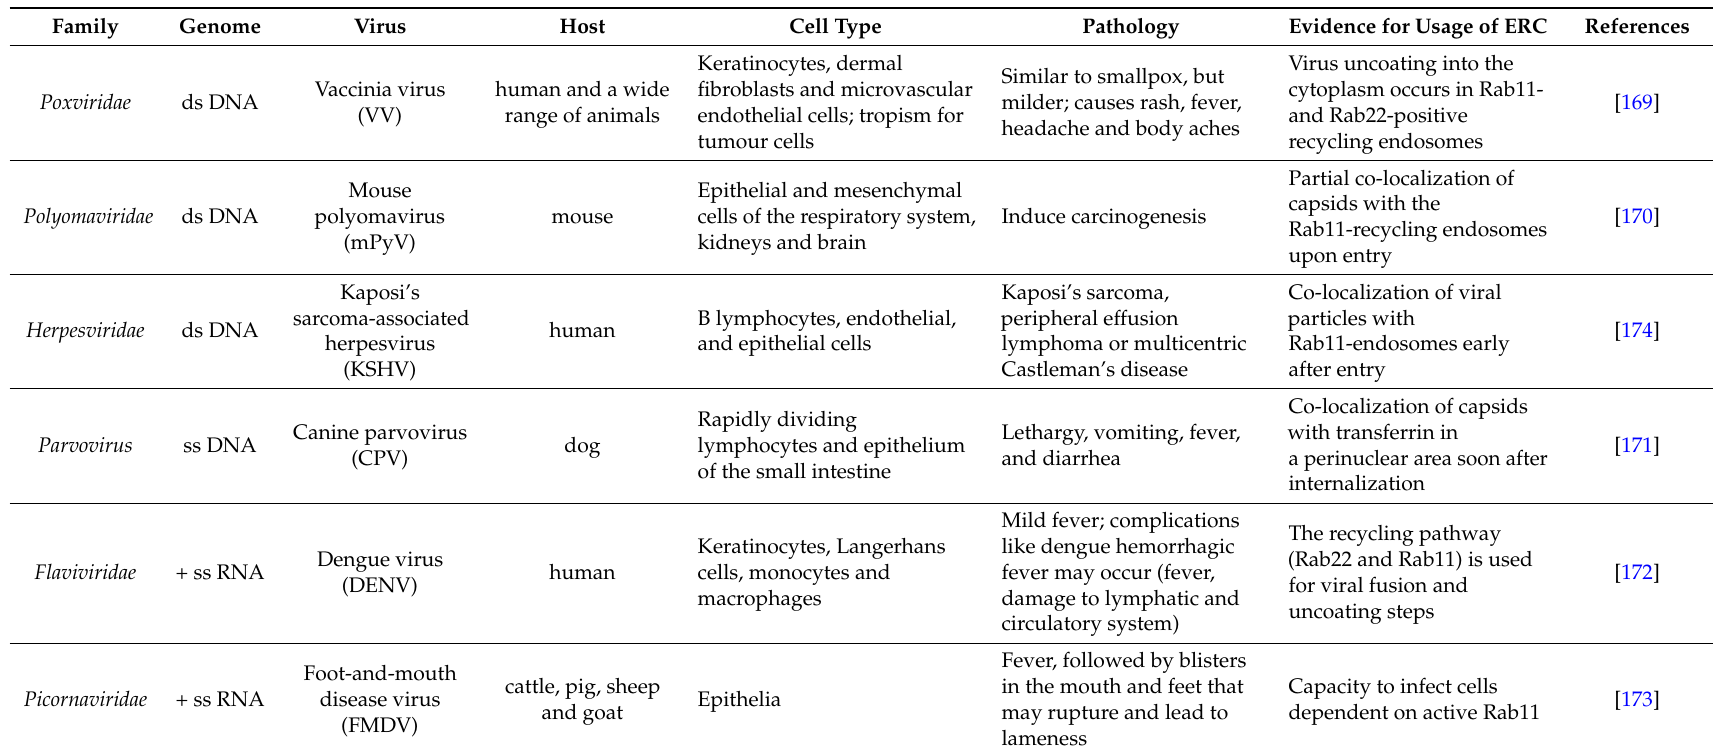
Table 2. Evidence for viral usage of the ERC at entry